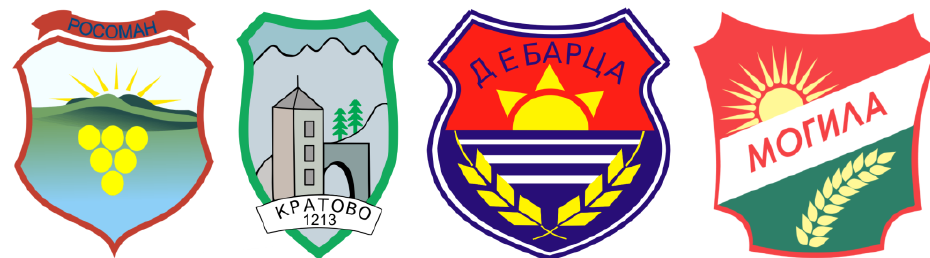
Figure 8. Sample of potentially heraldic arms: Negotino, Gostivar, Bogdanci, and Shtip.